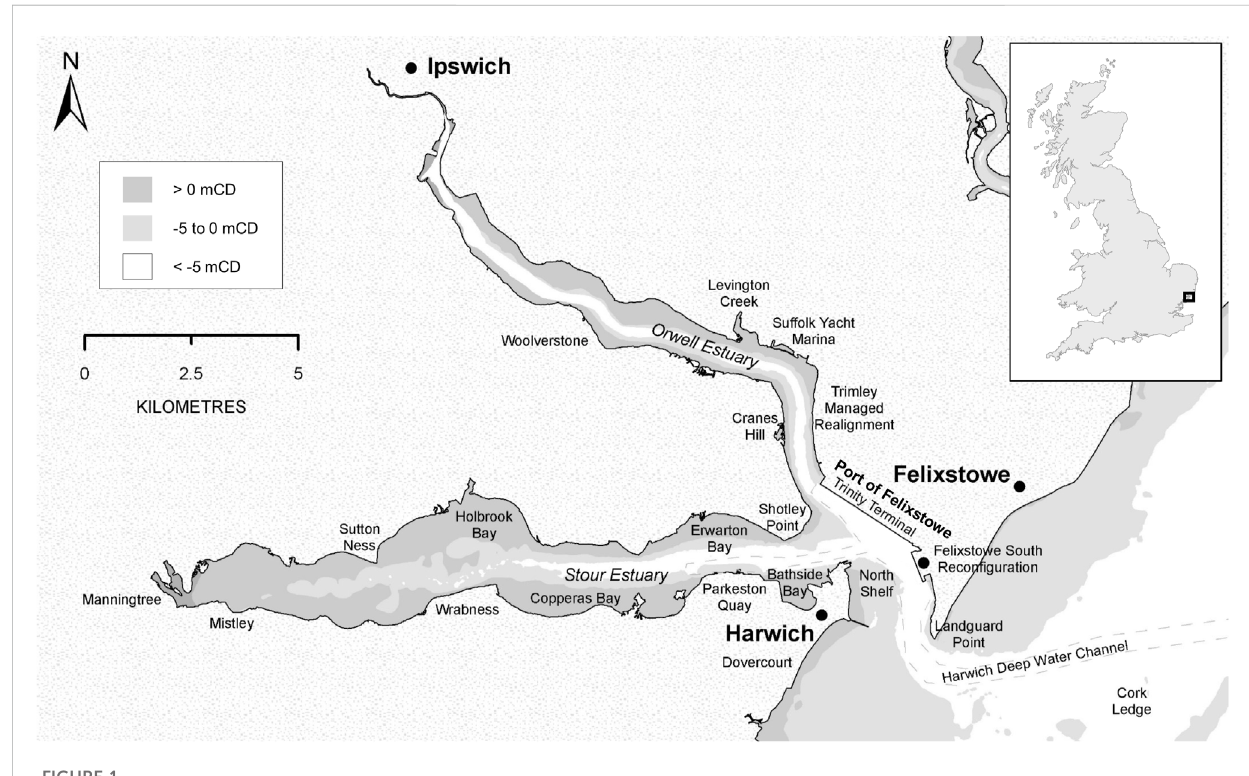
FIGURE 1 Stour/Orwell estuary system.